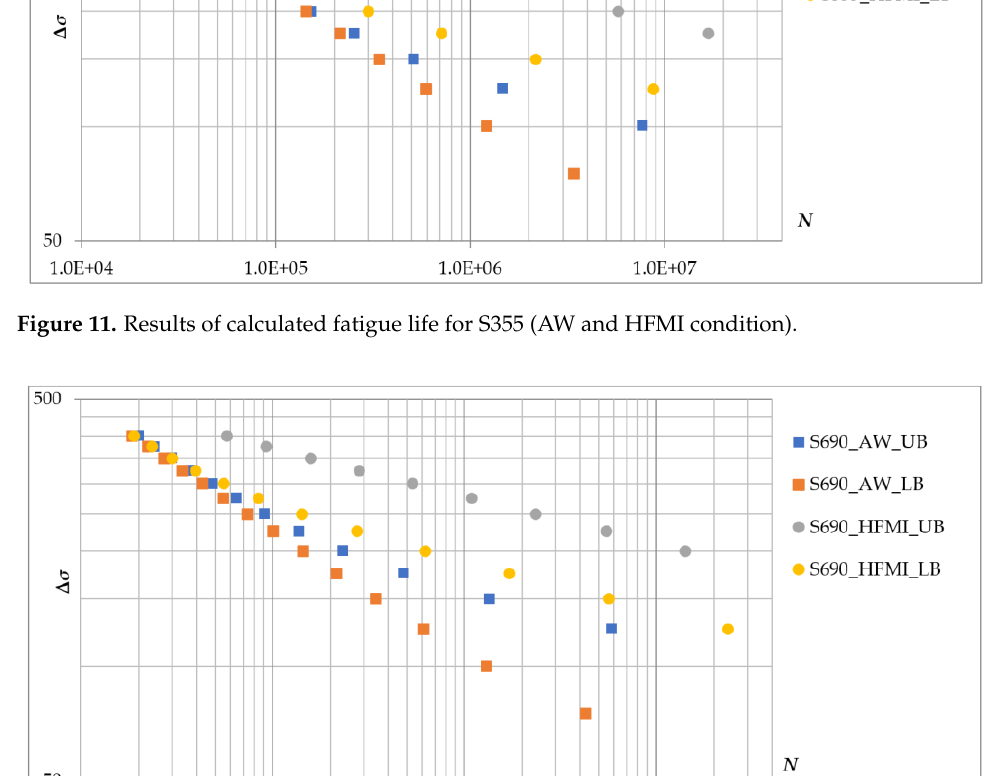
Figure 13. Results of calculated fatigue life for S960 (AW and HFMI condition). Results from Figures 10 – 13 show a significant increase in calculated fatigue lives for HFMI-treated details in comparison to the AW condition. The HFMI method improves the geometry of the weld toe and thus reduces the stress concentration factor, which ensures longer fatigue life. As mentioned before, the HFMI method also modifies the re- sidual stress state at the weld toe. It is able to introduce higher compressive residual stresses in high-strength steel, which has a significant influence on increasing the fatigue life. It is shown that HFMI-treated details for steel grade S960 (Figure 13) have much longer fatigue lives than the same detail made of steel grade S355 (Figure 10). To show the impact of steel quality more clearly, results for the HFMI-treated state (LB) are pre- sented in Figure 14 for three steel grades. It can be seen that details with a steel grade of S690 have increased fatigue lives in relation to S355, but are considerably lower in rela- tion to details made of steel S960.